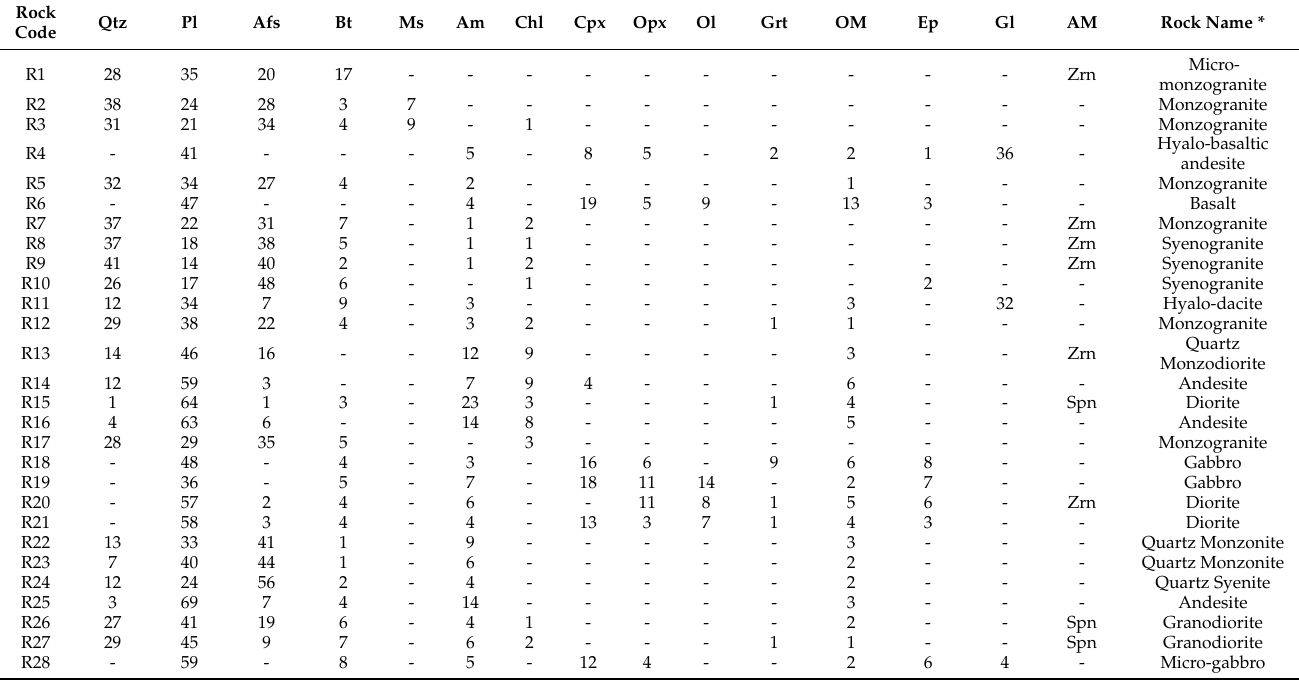
Table 1. Modal analysis and rock names of the studied rocks (the mineral constituents are given in percentage).